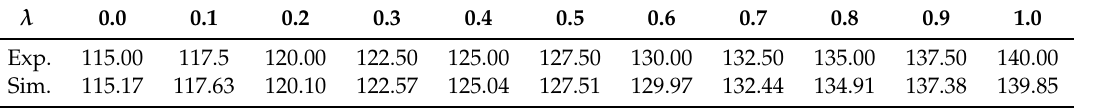
Table 1. Comparison of the expected value (Exp.) and simulated value